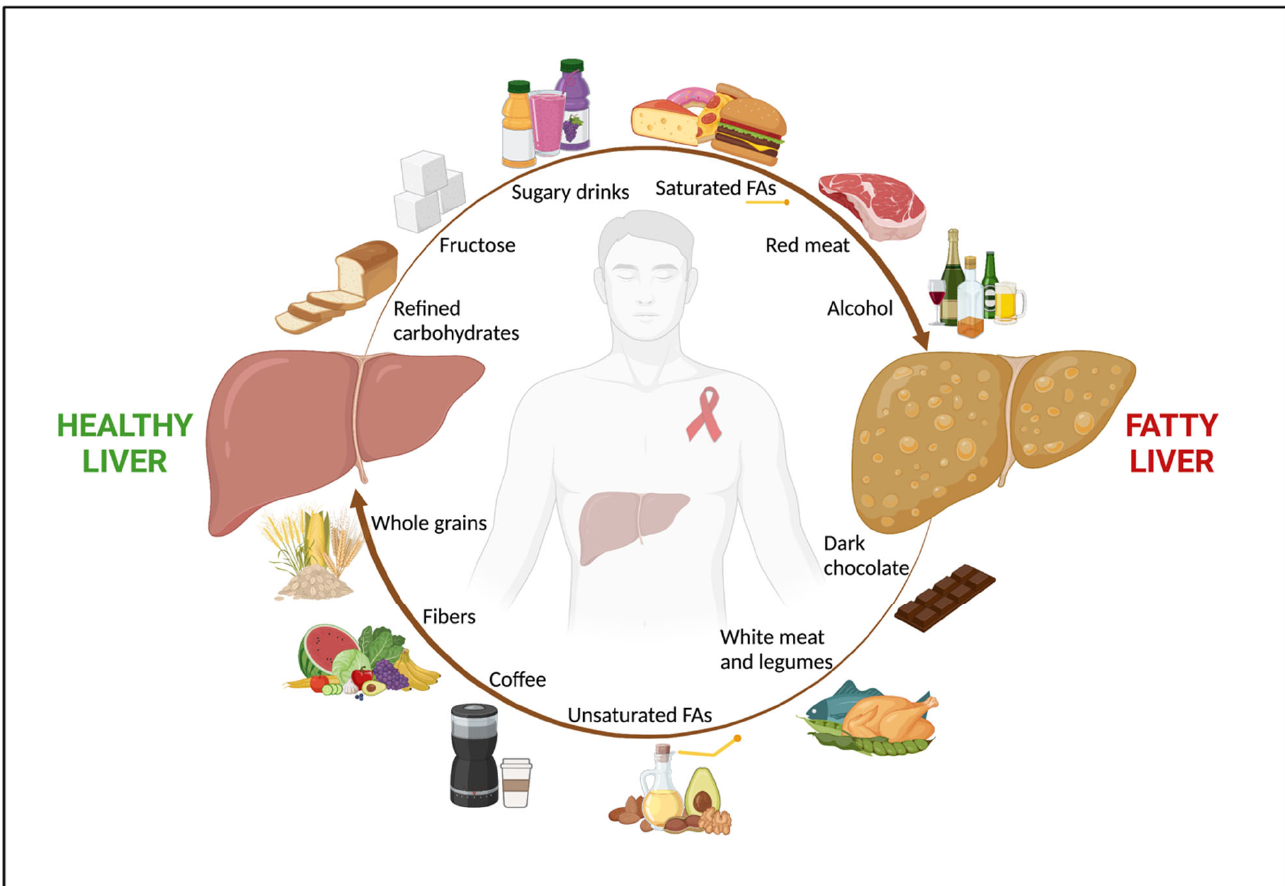
Figure 1. The role of nutrients in NAFLD in people with HIV. Among people with HIV, nutrition has a key impact in both NAFLD onset and regression. An unhealthy diet, rich in re fi ned carbohy- a key impact in both NAFLD onset and regression. An unhealthy diet, rich in refined carbohydrates, fructose and sugar-added beverages, saturated FAs, and red and processed meat, along with alcohol alcohol abuse, are associated with fa tt y liver. Conversely, a healthy diet, with high intake of fruits, abuse, are associated with fatty liver. Conversely, a healthy diet, with high intake of fruits, vegetables, whole grains, which are good sources of fibers, unsaturated FAs, white meat, dark chocolate, and coffee shows a beneficial effect on NAFLD. Abbreviations : NAFLD; non-alcoholic fatty liver disease; and FAs, fatty